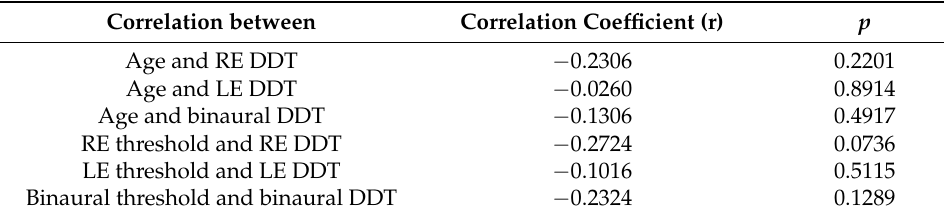
Table 4. Pearson correlation of age and threshold with the right ear, left ear, and binaural dichotic digits test.